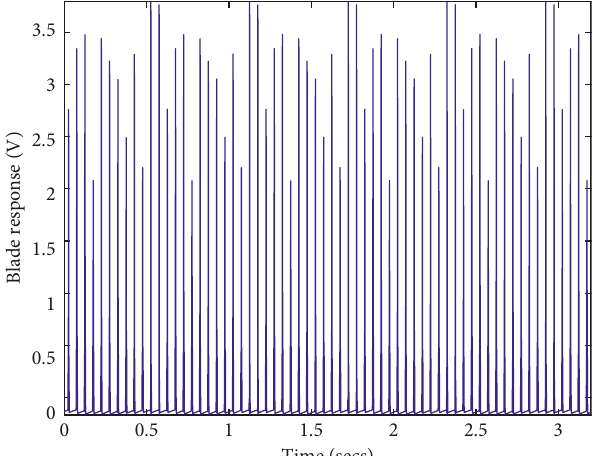
Figure 8: Speed variation.